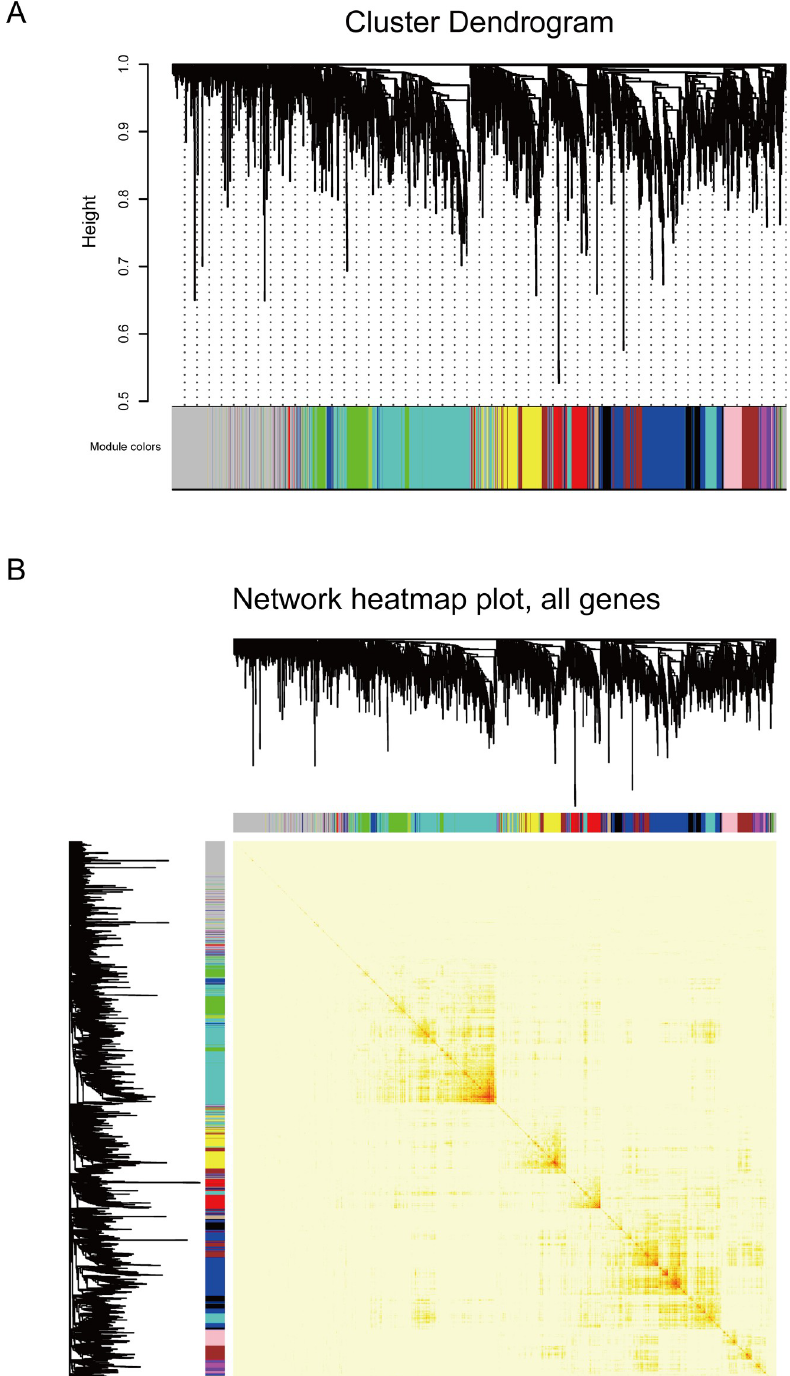
Fig 4. Co-expression analysis for mining function module. (A) Clustering dendrogram of genes. A total of 13 colors corresponding to 13 modules. X-axis represents gene and y-axis represents the height of the gene tree. (B) Heat map of the expression of the module gene. Light color represents low overlap and progressively darker red color represents higher overlap. Blocks of darker colors along the diagonal are the modules.